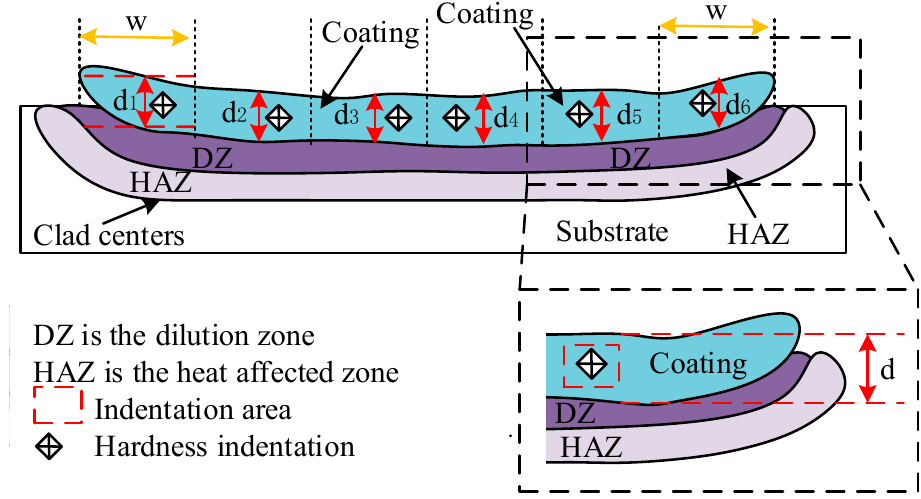
Figure 3. Schematic diagram of the measurement of coating micro-hardness. Table 2. L 27-(3 13 ) orthogonal table for preparation of Ti(C, N) ceramic coating by laser cladding.